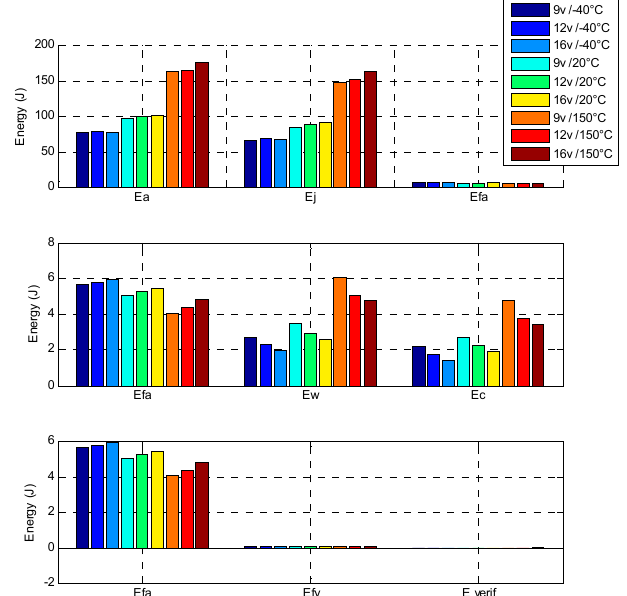
Figure 22. Indirect drive energy balance at different voltages and temperatures. E a : the electrical energy consumption; E j : the Joule effect losses; E fa : the actuator mechanical losses; E w : the wire joule losses; E c : the H-bridge Joule losses and E fv : the valve mechanical losses.